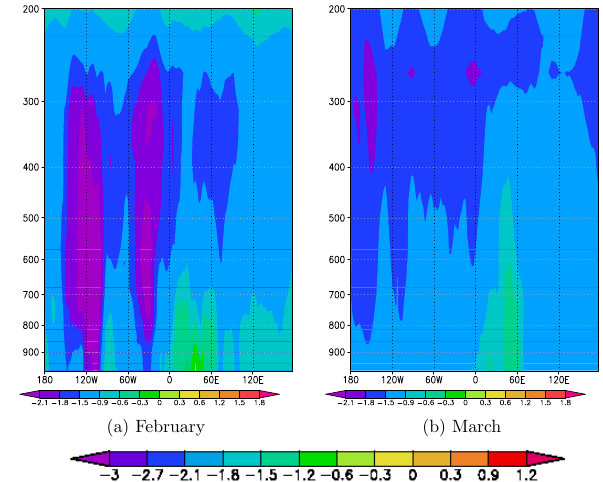
Fig. 13. Monthly mean differences between the assimilation run and free model run at 40 ◦ N, for February and March, 2006.